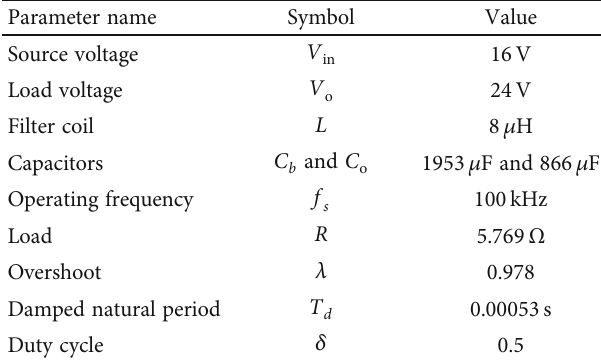
Table 1: Speci fi cation of